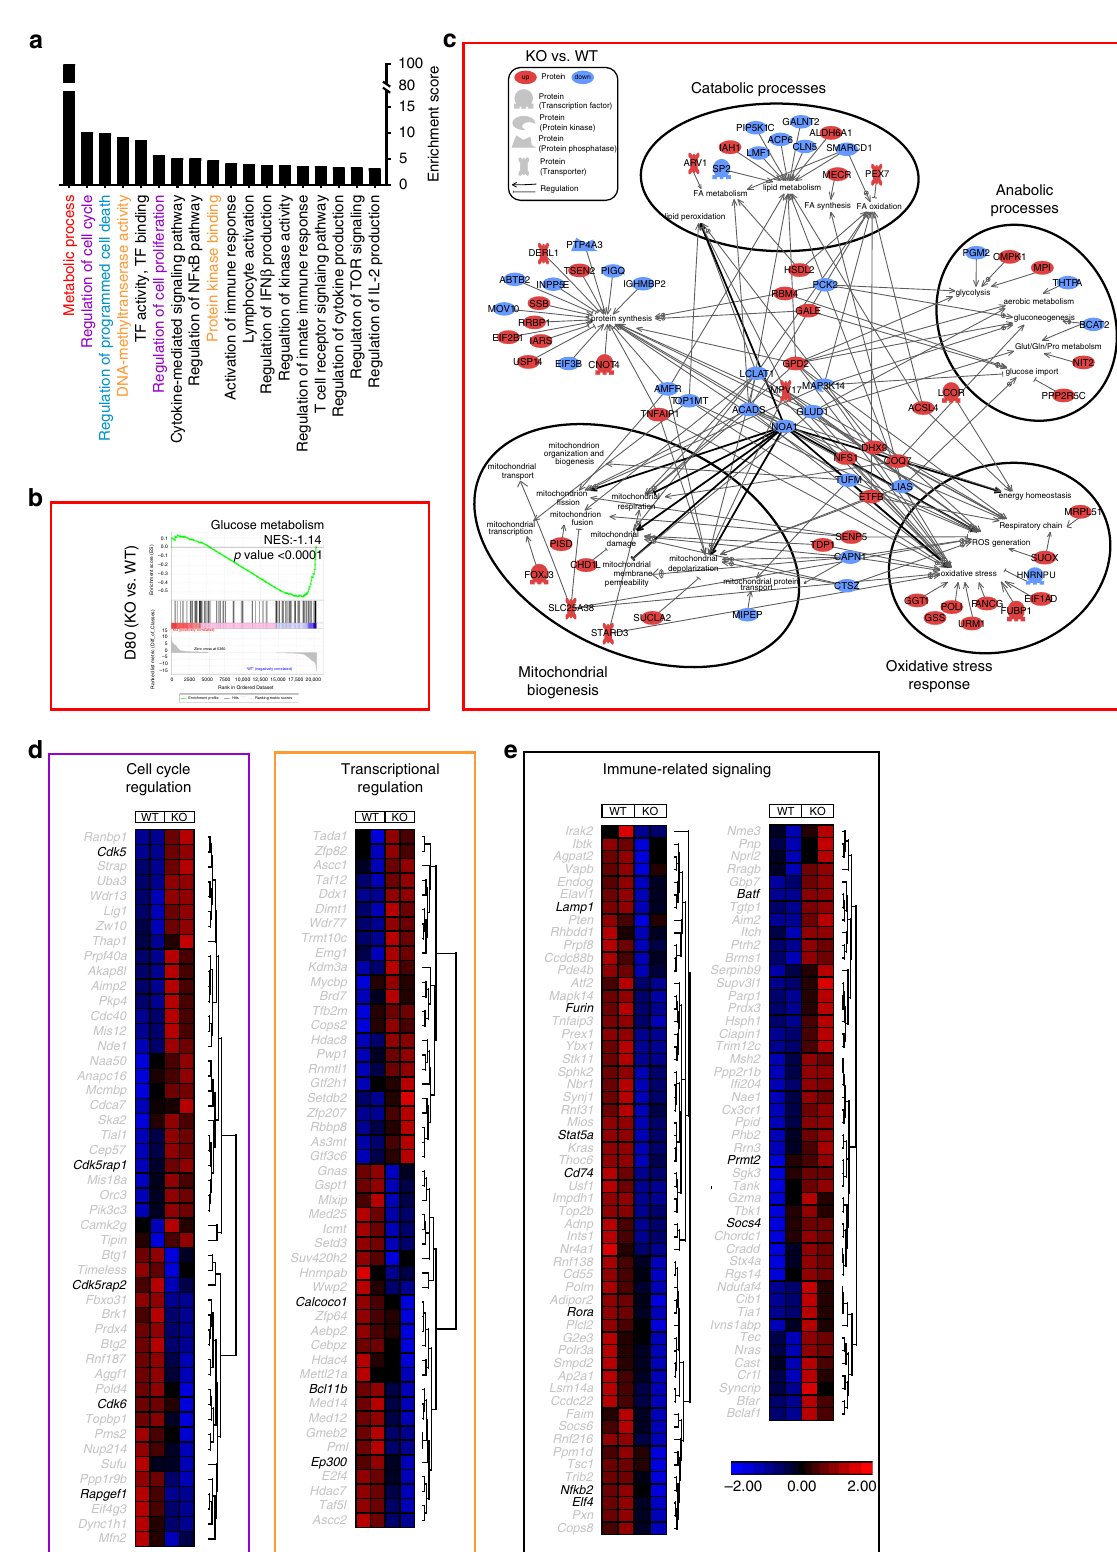
Fig. 5 Gene expression analysis of Tnik WT and Tnik − / − memory p14 T cells. a GO enrichment analysis of the biological pathways signi fi cantly affected in D80 KO vs WT p14 T cells. b GSEA for glucose metabolism. c Gene network and canonical pathway analysis highlighting the regulation and interrelation of metabolic assigned processes. d , e Heatmap of differentially expressed genes assigned to speci fi c clusters in KO vs WT memory p14 T cells. Highlighted genes in the clustered heatmaps are discussed. NES Normalized Enrichment Score. Also see Supplementary Fig. 5 and Supplementary Data 2. Source data are provided as a Source Data fi